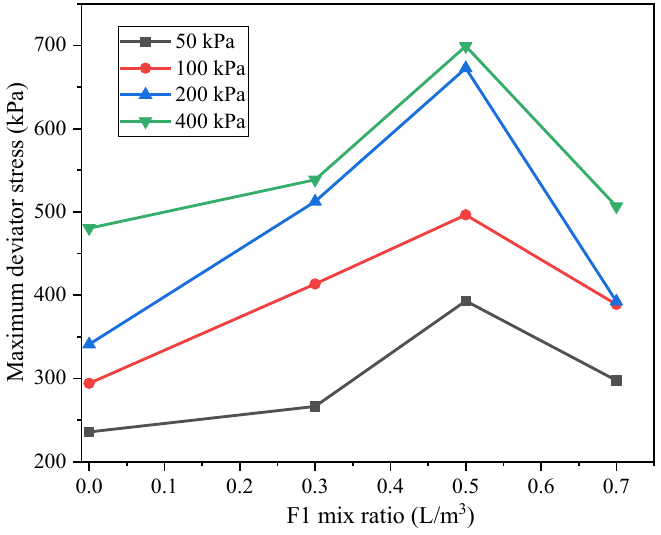
Figure 6. Relationship between maximum deviator stress of red clay and F1 content.